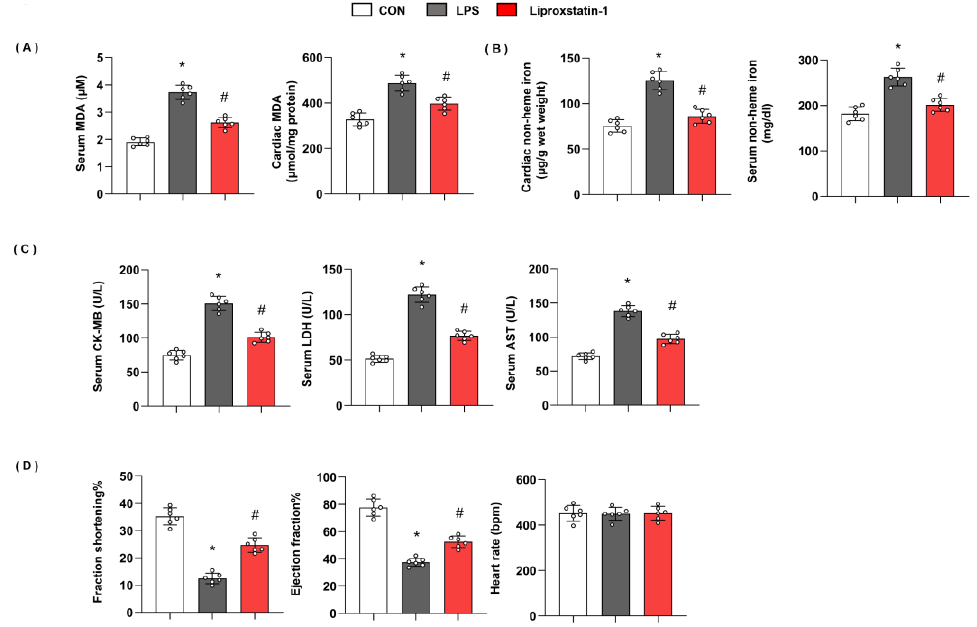
Figure 2. Ferroptosis plays an essential role in LPS-induced cardiac injury. ( A ) Serum and cardiac MDA level in mice injected with shTMEM43 under LPS challenge ( n = 6). ( B ) Serum and cardiac non-heme iron in mice injected with shTMEM43 under LPS challenge ( n = 6). ( C ) Serum CK-MB, LDH, and AST in each group ( n = 6). ( D ) Echocardiography result in each group ( n = 6). * p < 0.05 vs. CON group. # p < 0.05 vs. LPS group.